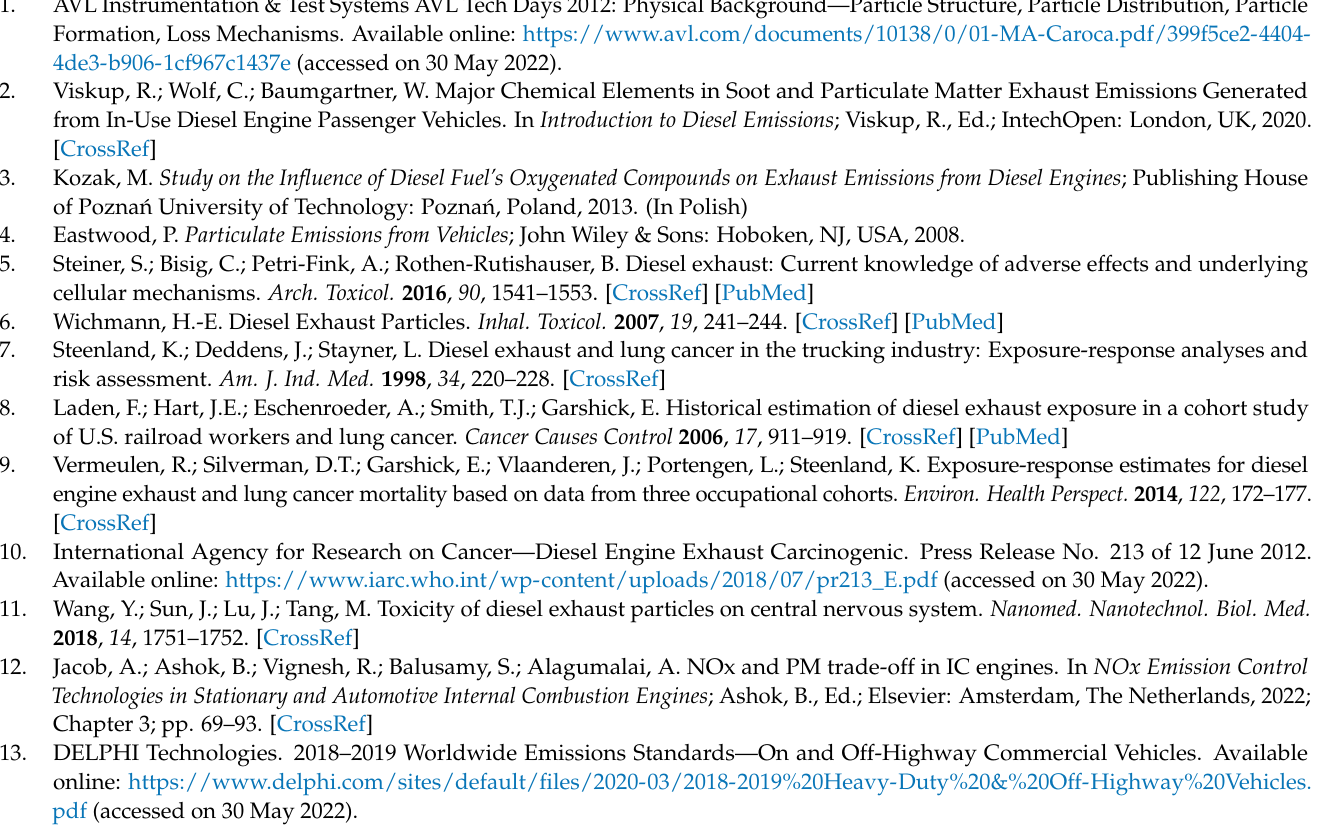
Figure A5. Percentage changes in NO x emissions over the NEDC from a test car with fuels containing individual oxygenates at a concentration of 5% v / v compared to running on conventional diesel